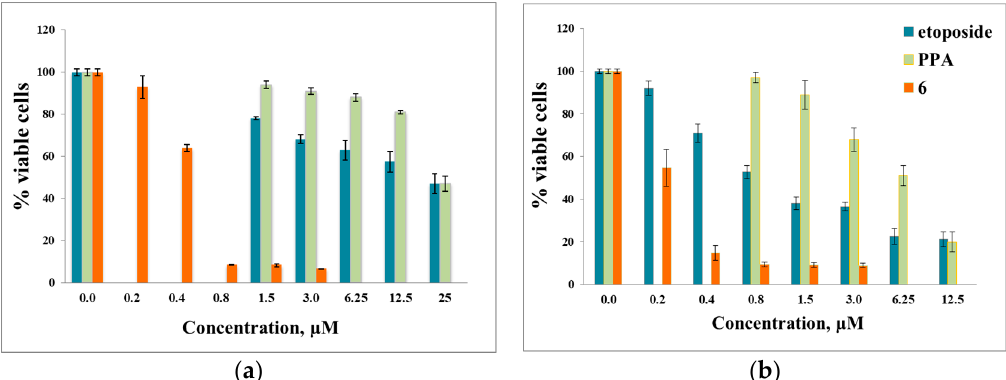
Figure 1. ( a ) The in vitro effects of compound 6 on the cell viability of human HCT-116 cell line; ( b ) The in vitro effects of compound 6 on the cell viability of human NCI-H929 cell line.